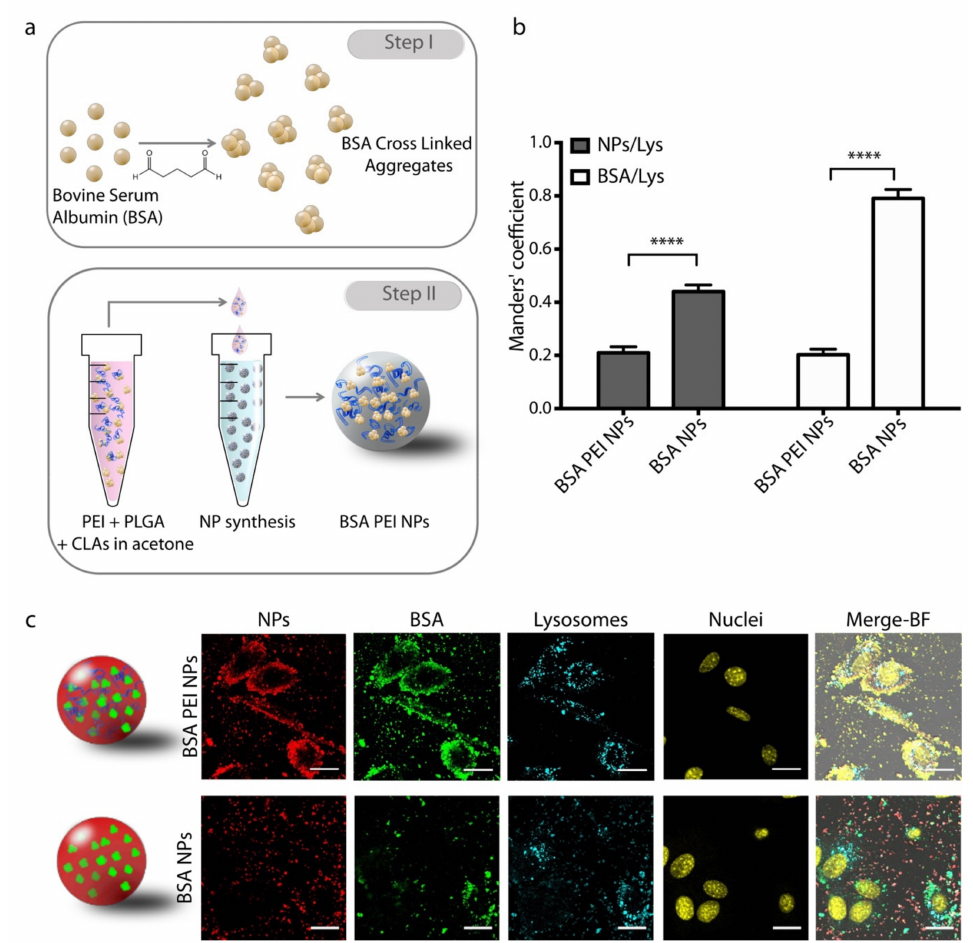
Figure 1. ( a ) Schematic representation of bovine serum albumin (BSA) poly(ethylene imine)(PEI) nanoparticles (NP) synthesis. ( b ) Manders’ coe ffi cient of NP / Lysosomes and BSA / Lysosomes overlap in NIH-3T3 cells. Error bars represent the Standard Error of the Mean, n = 10. ( c ) Representative confocal images of NIH-3T3 cells incubated with BSA PEI NPs and BSA NPs imaged 2 h upon treatment. Scale bars: 20 µ